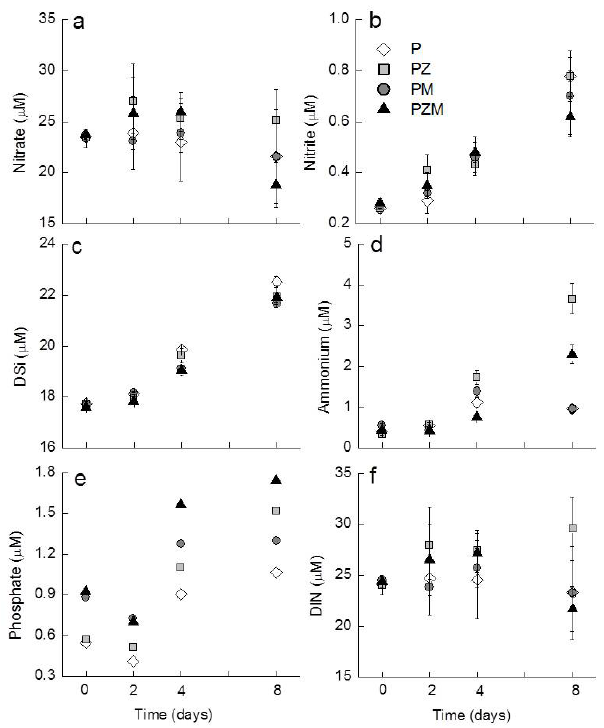
Fig. 8. Concentrations of (a) nitrate, (b) nitrite, (c) DSi, (d) ammo- nium, (e) phosphate, and (f) DIN (nitrate+nitrite+ammonium) in the tanks.